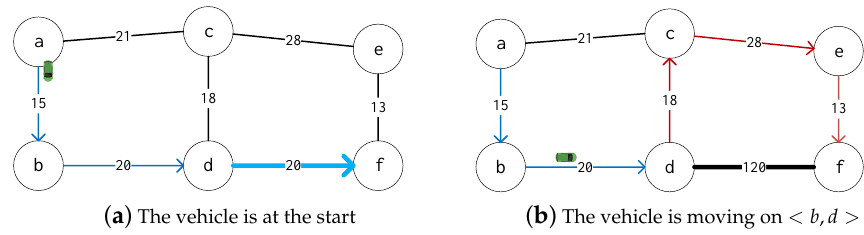
Figure 4. Example of route updating when traffic jam occurs. (When the road < d , f > is